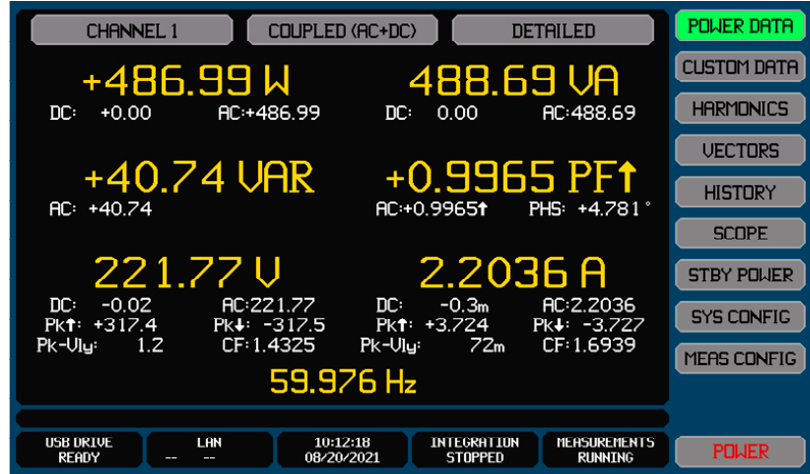
Figure 20. Apparent power, real power, and power factor value measured on the drive developed.